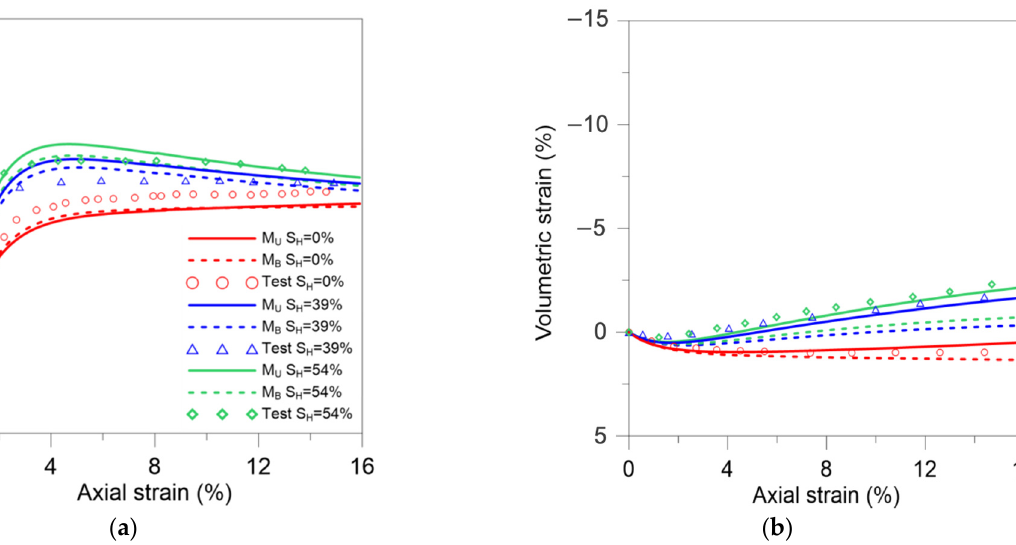
Figure 8. Modeling the tests reported in Hyodo et al. [6] at 𝜎 3 = 3 MPa. ( a ) Deviatoric stress versus axial strains; ( b ) volumetric strain versus axial strains.